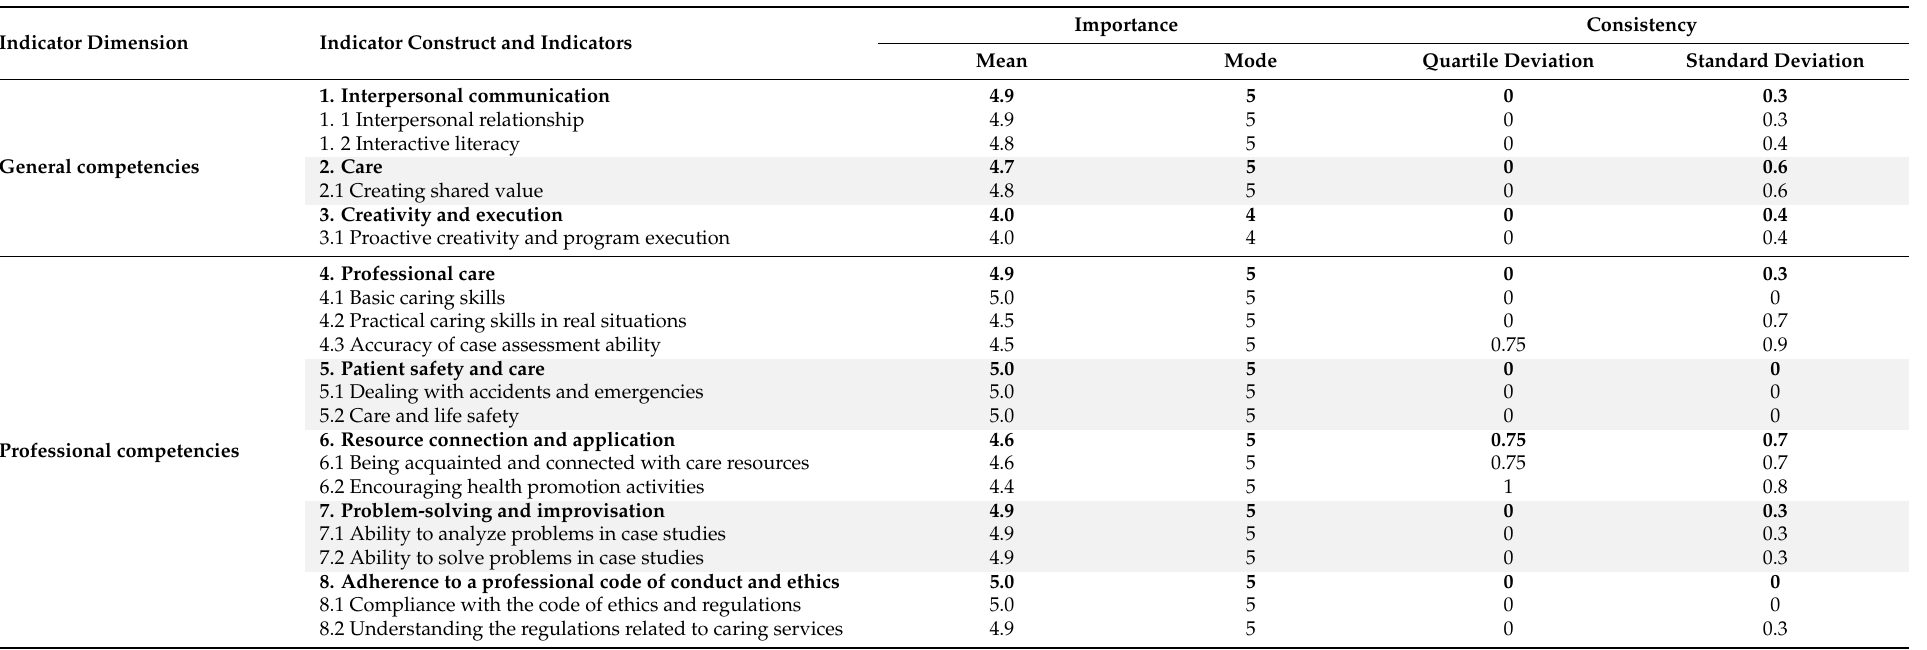
Table 4. Overall importance and consistency of the core competencies for care service education in vocational high schools ( n =